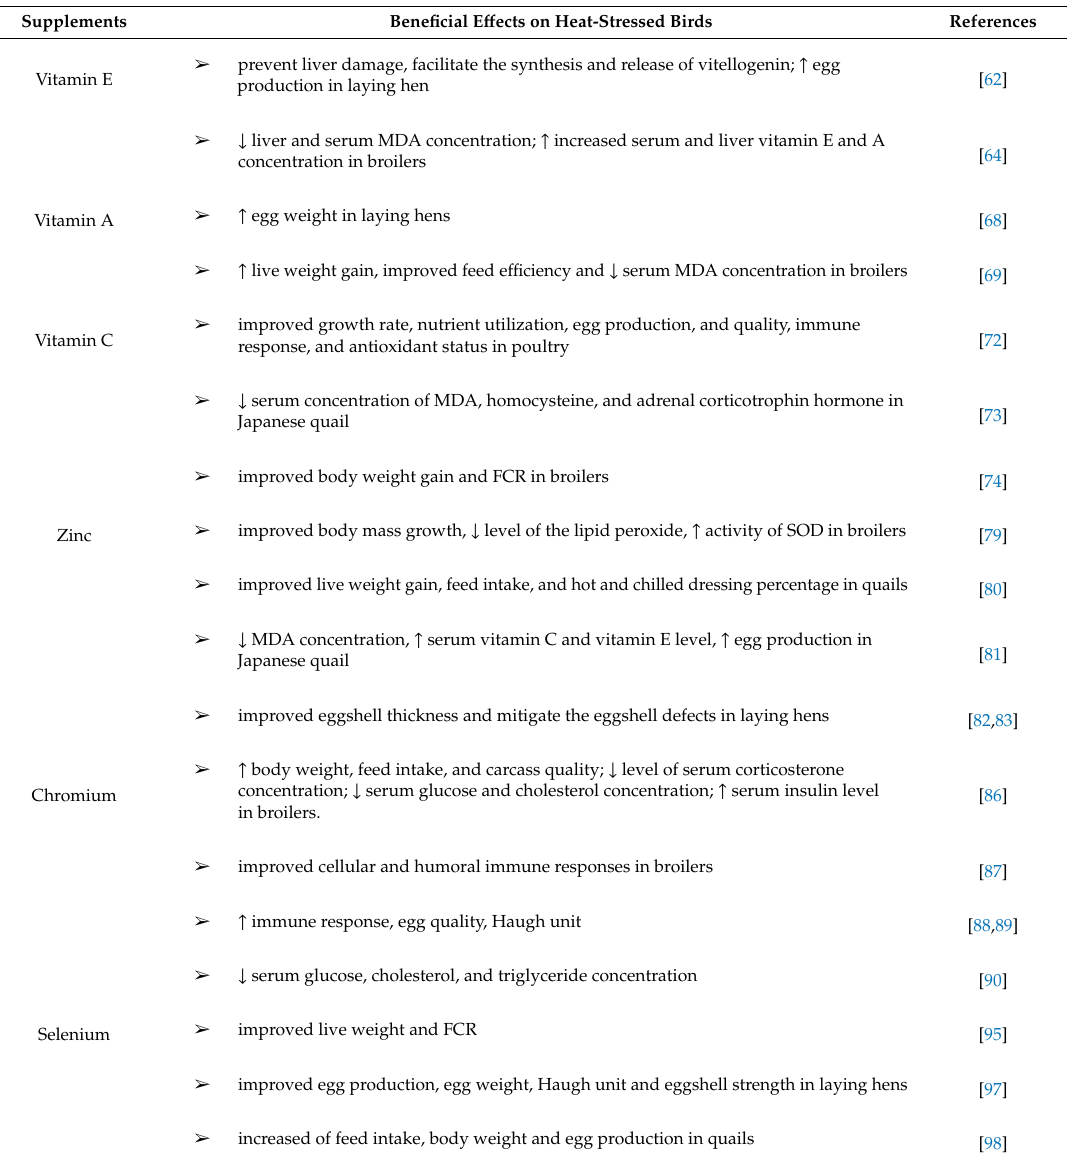
Table 1. Summary of the beneficial e ff ects of vitamins, minerals, phytochemicals, and osmolytes in heat-stressed